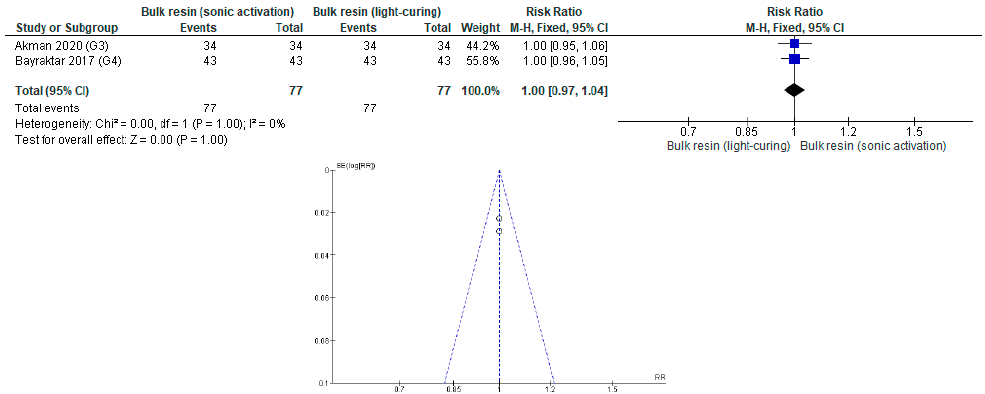
Figure A19. Absence of Post-Operative Sensitivity: Conventional Resin versus Bulk Resin According to the Technique Used.